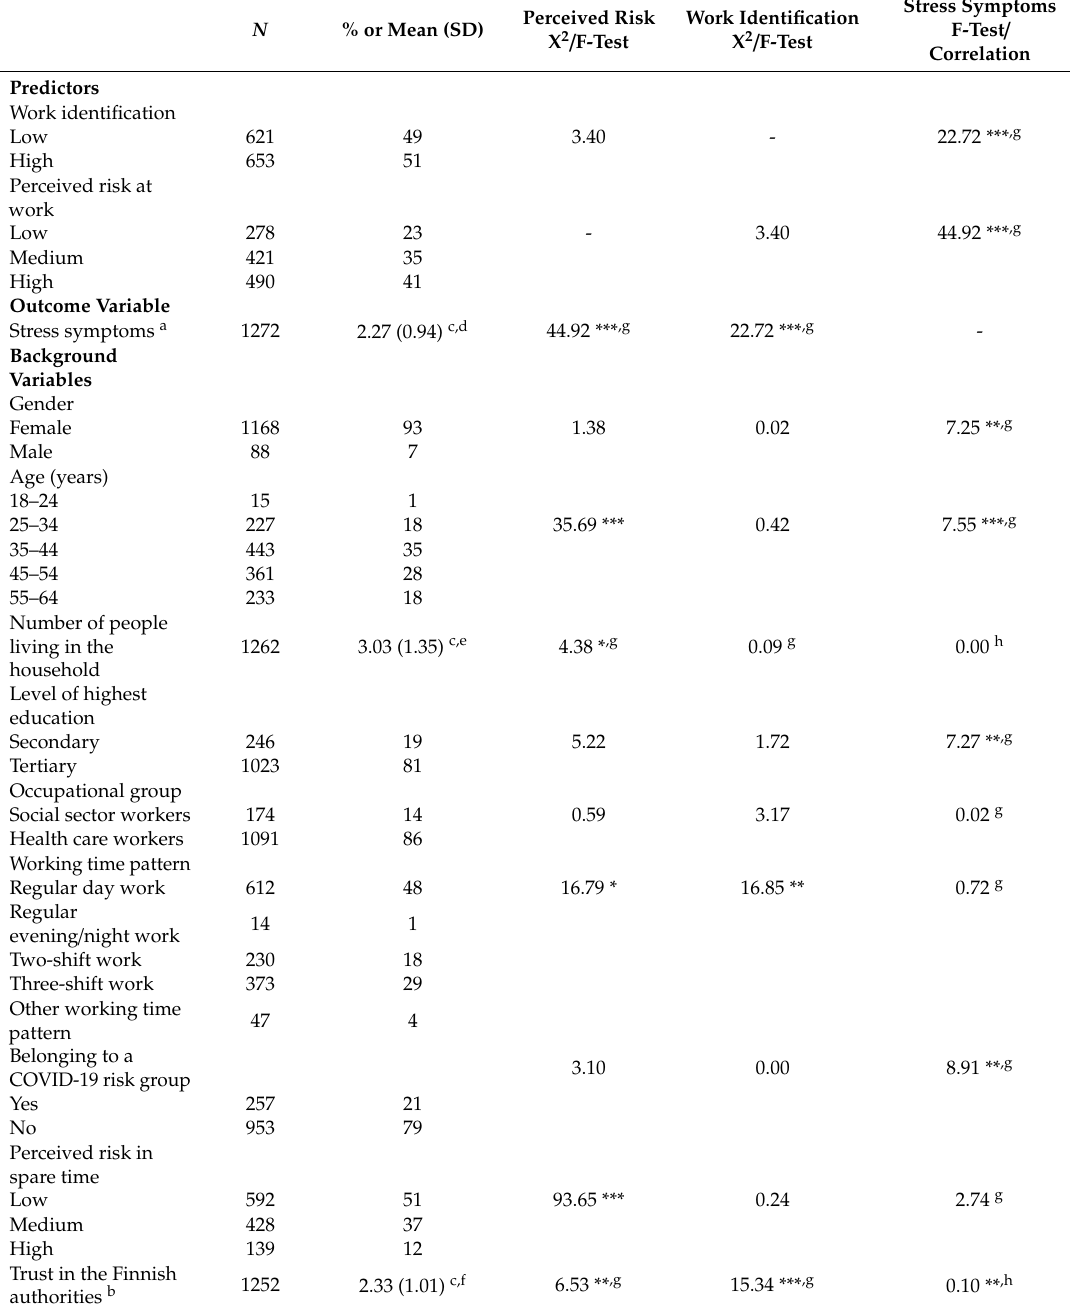
Table 1. Descriptive statistics of all variables and their unadjusted associations with work identification, perceived COVID-19 risk at work, and stress symptoms ( N = 1159–1279). Stress Symptoms Perceived Risk Work Identification N % or Mean (SD) F-Test / X 2 / F-Test X 2 / F-Test